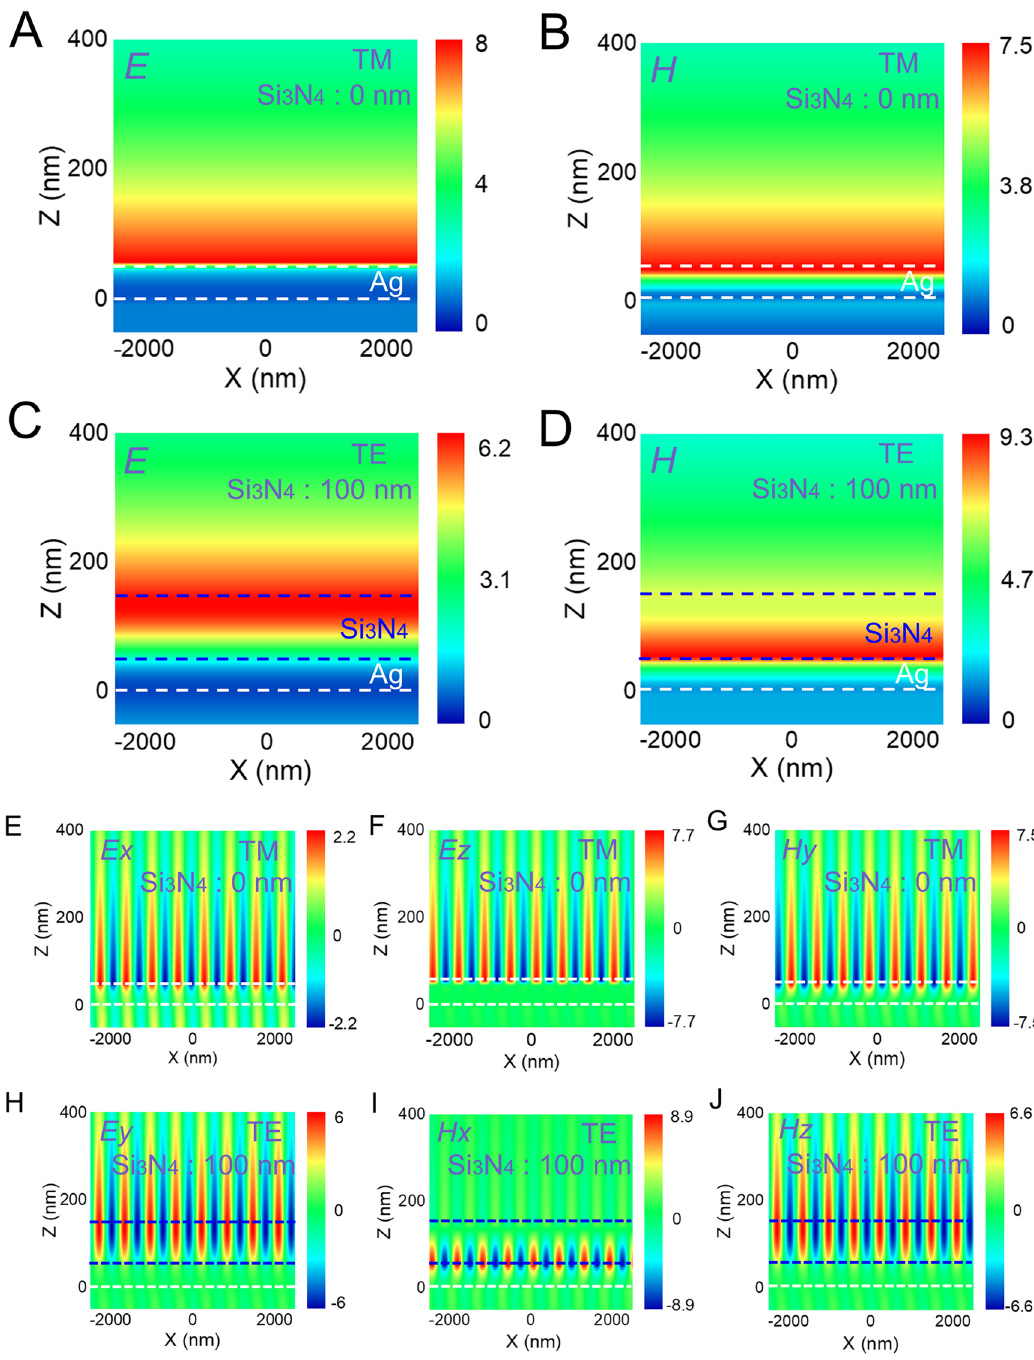
Figure 2: Electric and magnetic field distributions calculated for the lowest-order TM and TE waves. Total electric field distribution in the XZ plane calculated for the TM (A) and TE (C) wave. The corresponding magnetic fi eld distributions are shown in (B) and (D), respectively. (E) and (F) The E x and E z components for the TM wave. (G). The H y component for the TM wave. (H) The E y component for the TE wave. (I) and (J) The H x and H z components for the TE